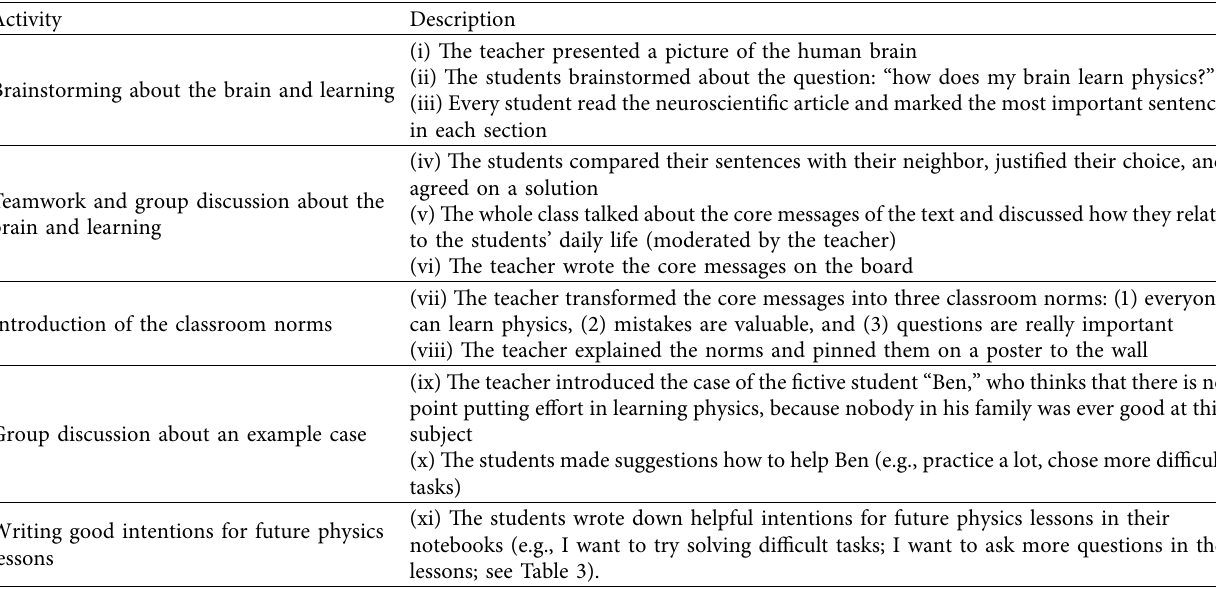
Figure 1: Timescale of the training and the points of assessment. Implicit parts are marked by the cross-hatched areas; explicit training sessions are marked with A and Table 1: Training Session A.